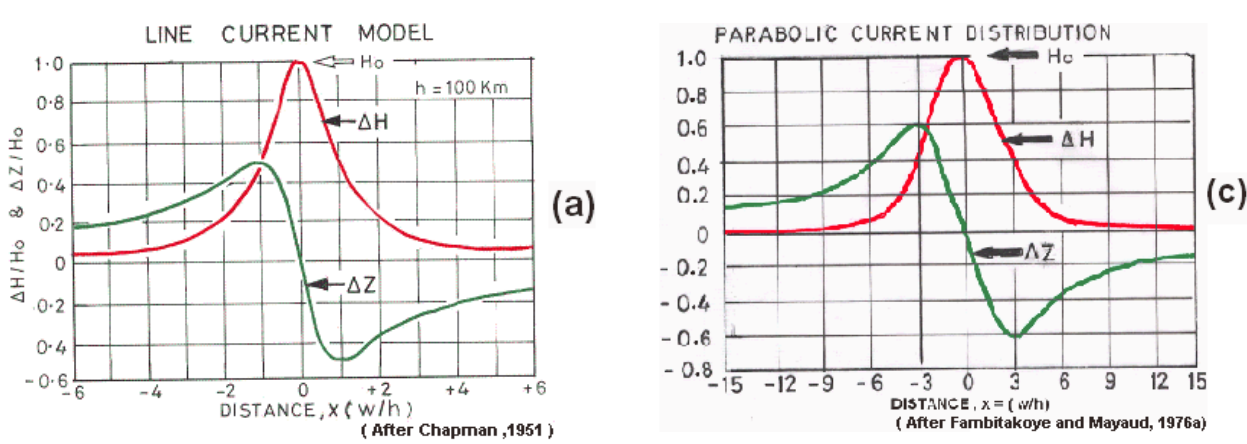
Fig. 2c. The latitudinal variation of H and Z components of the surface field of a horizontal band of eastward current of parabolic cross section intensity (after Fambitakoya and Mayaud, 1976).